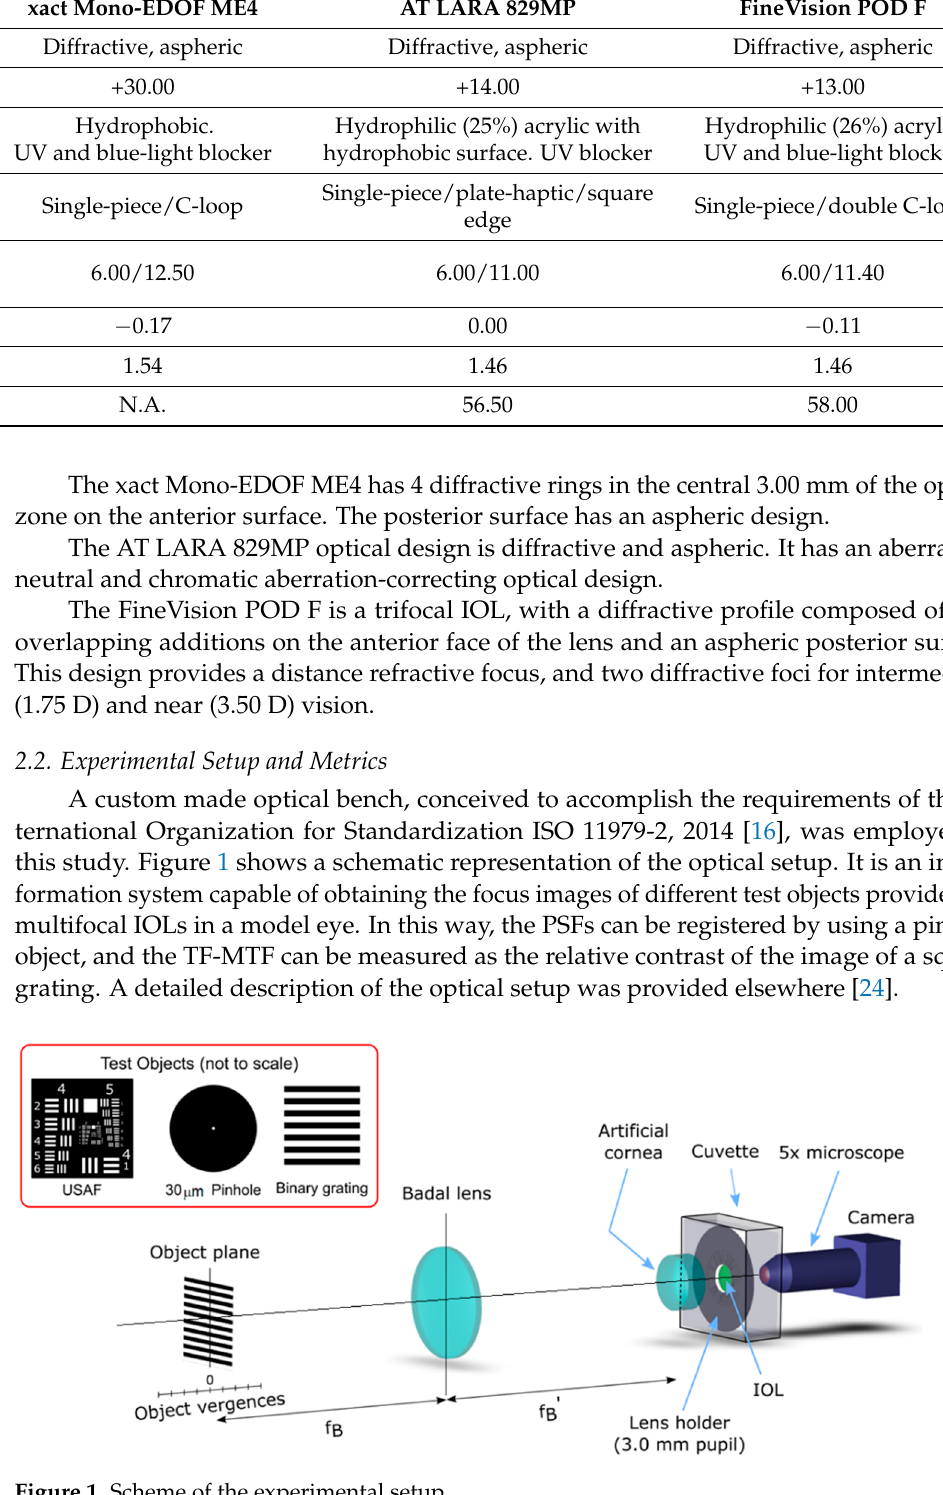
Figure 1. Scheme of the experimental setup.